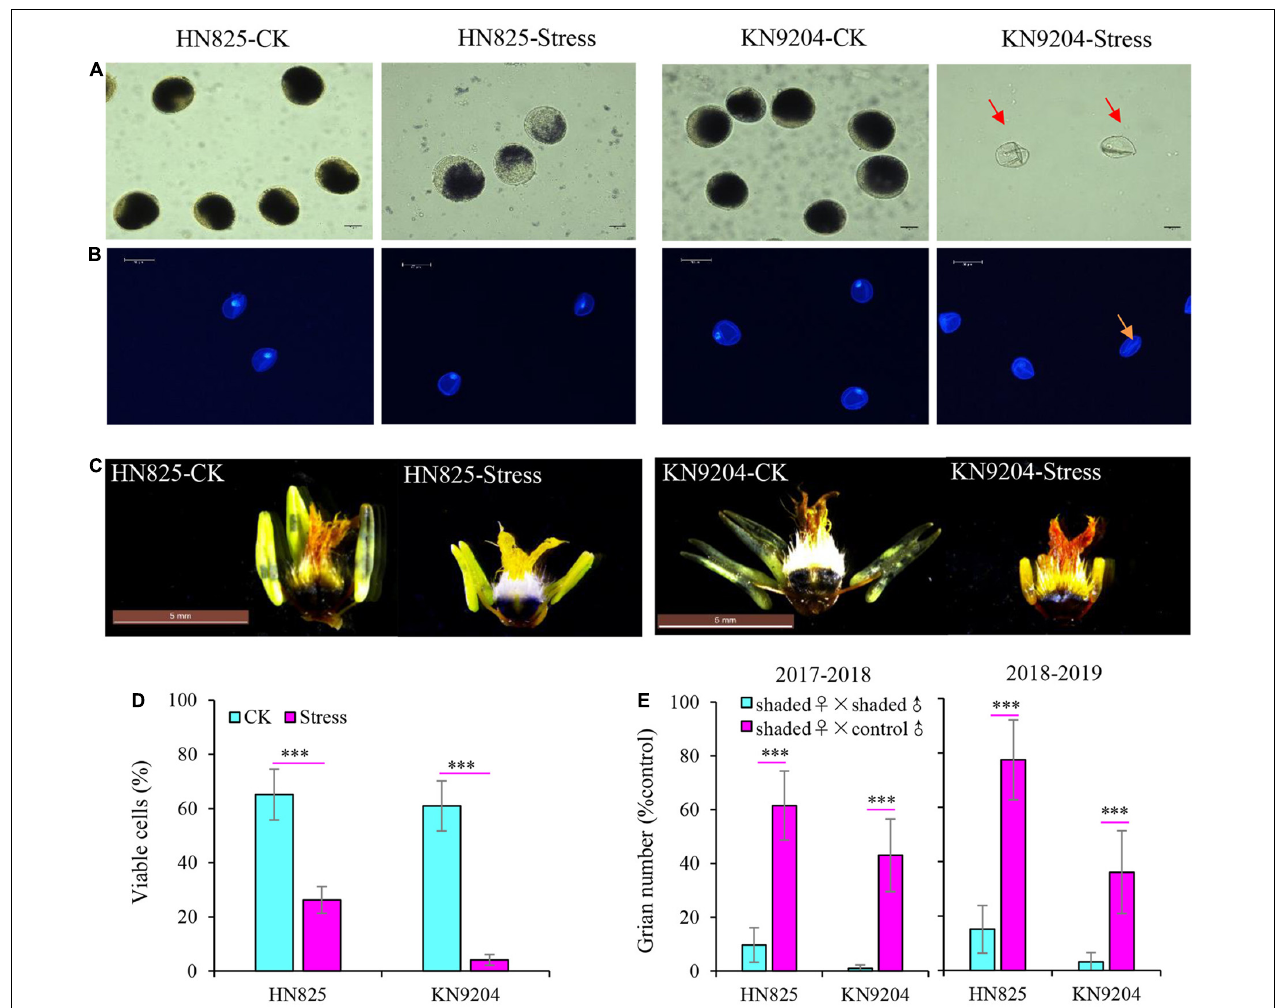
FIGURE 3 | Effects of low light stress on the anther and ovary fertility in ‘HN825’ and ‘KN9204’. Pollen of the two cultivars was stained with I 2 -KI solution (A) and DAPI solution (B) to determine fertility and development. Starch staining was carried out on anthers and ovaries of control (CK) and stressed plants (C) . The rate of viable pollen cells in control and stress treatments were measured at anthesis (D) . Stressed wheat and control wheat was used in cross-pollination experiments to test the effect of low light stress on anthers and ovary fertility (E) . The scale bar indicates 20 µ m (A) , 50 µ m (B) , and 5 mm (C) , respectively. Shaded Significant differences between treatments are indicated by asterisks ( ∗∗∗ P < 0.001, Student’s t